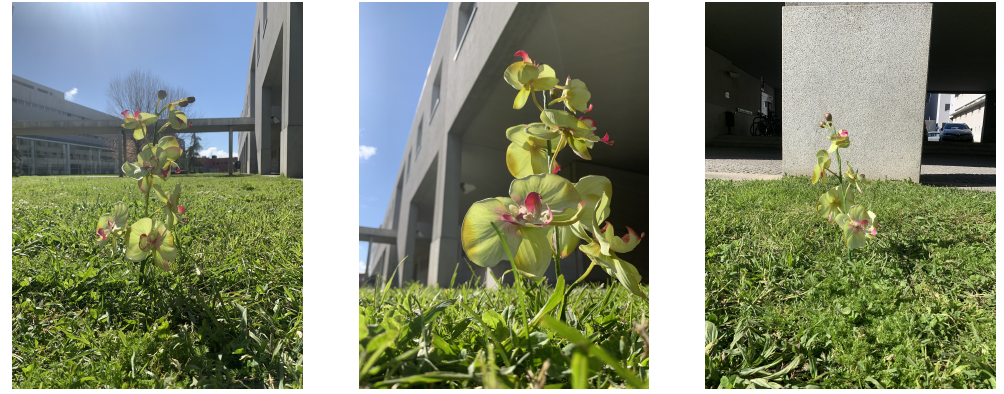
Figure 4. Sample images from the